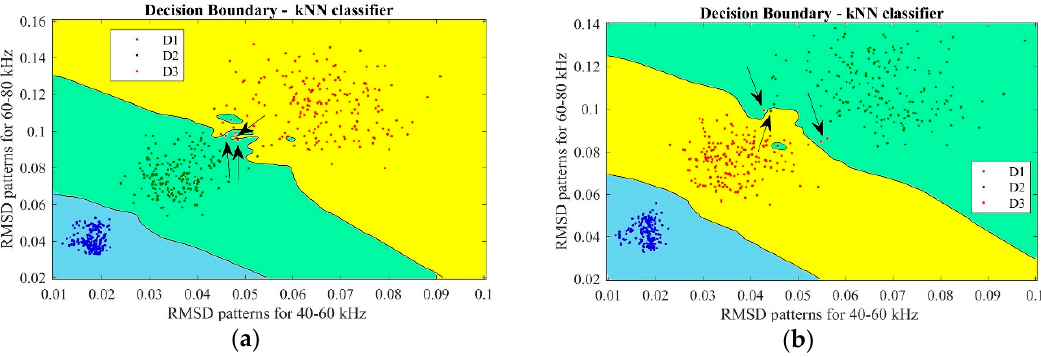
Figure 9. k -NN results via decision boundary graphics for the best ANN models in experimental case #2: ( a ) model#5 ; and ( b ) model#7 ( b ).